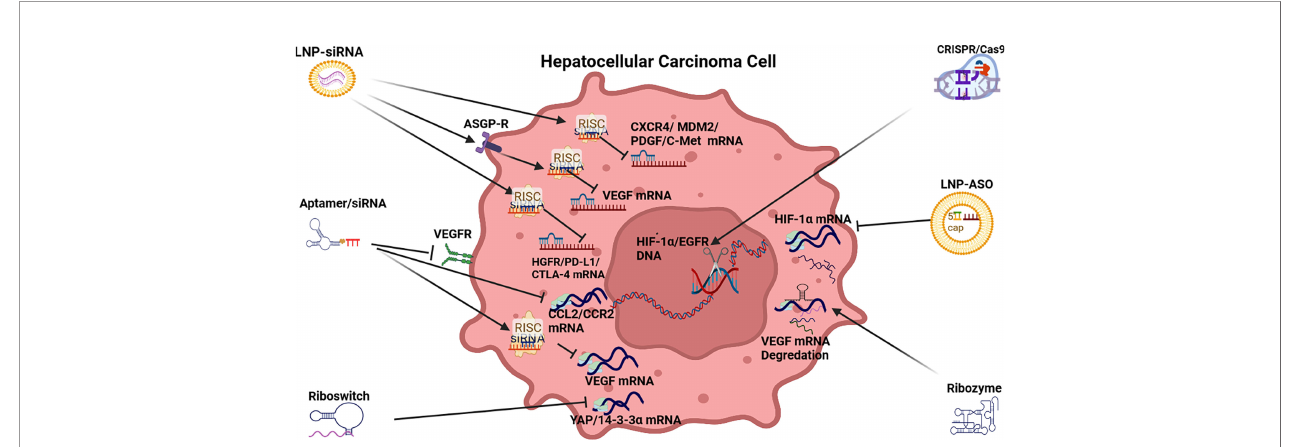
FIGURE 3 | RNAi anti-angiogenic strategies. LNP-siRNA (Lipid nanoparticles for targeted small interfering RNA delivery), CRISPR/Cas9 V (clustered regularly interspaced short palindromic repeats/CRISPR-associated protein 9), LNP-ASO (lipid nanoparticle associated antisense oligonucleotide), siRNA (small interfering RNA). VEGFR (vascular endothelial growth factor receptor), ASGPR (asialoglycoprotein receptor), RISC (RNA-induced silencing complex), HIF-1 a (hypoxia-inducible factor 1-alpha, a subunit of a heterodimeric transcription factor hypoxia-inducible factor 1 that is encoded by the HIF1A gene), CCL2/CCR2 (chemokine CCL2 and its main receptor CCR2 ), HGFR/PD-L1/CTLA-4 (human growth factor receptor/programmed death-ligand 1/constitutively expressed in regulatory T cells), CXCR4/ MDM2/PDGF/C-Met [chemokine receptor/murine double minute 2 protein/platelet-derived growth factor/tyrosine-protein kinase Met or hepatocyte growth factor receptor